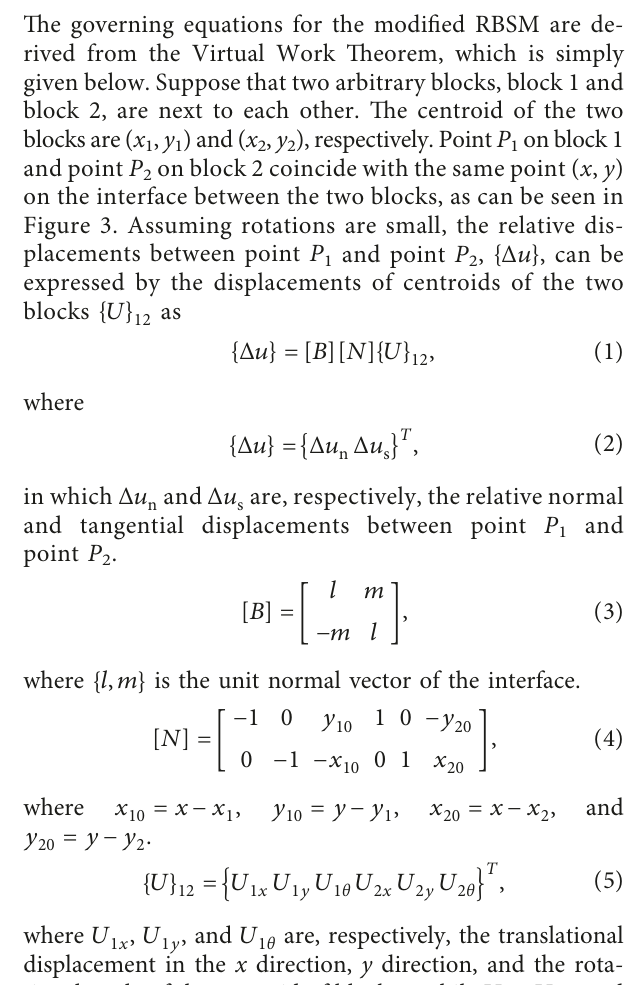
placements between point P 1 and point P 2 ,